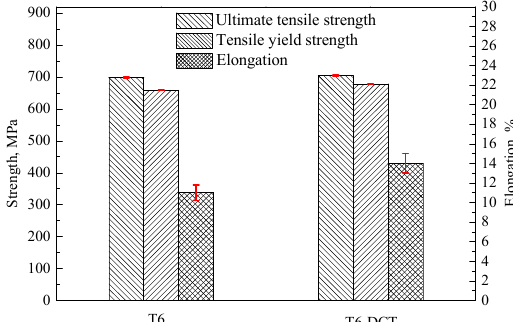
Figure 1. Tensile properties of indirectly extruded 7A99 aluminum alloy plates, subjected to T6 and T6-DCT treatments.